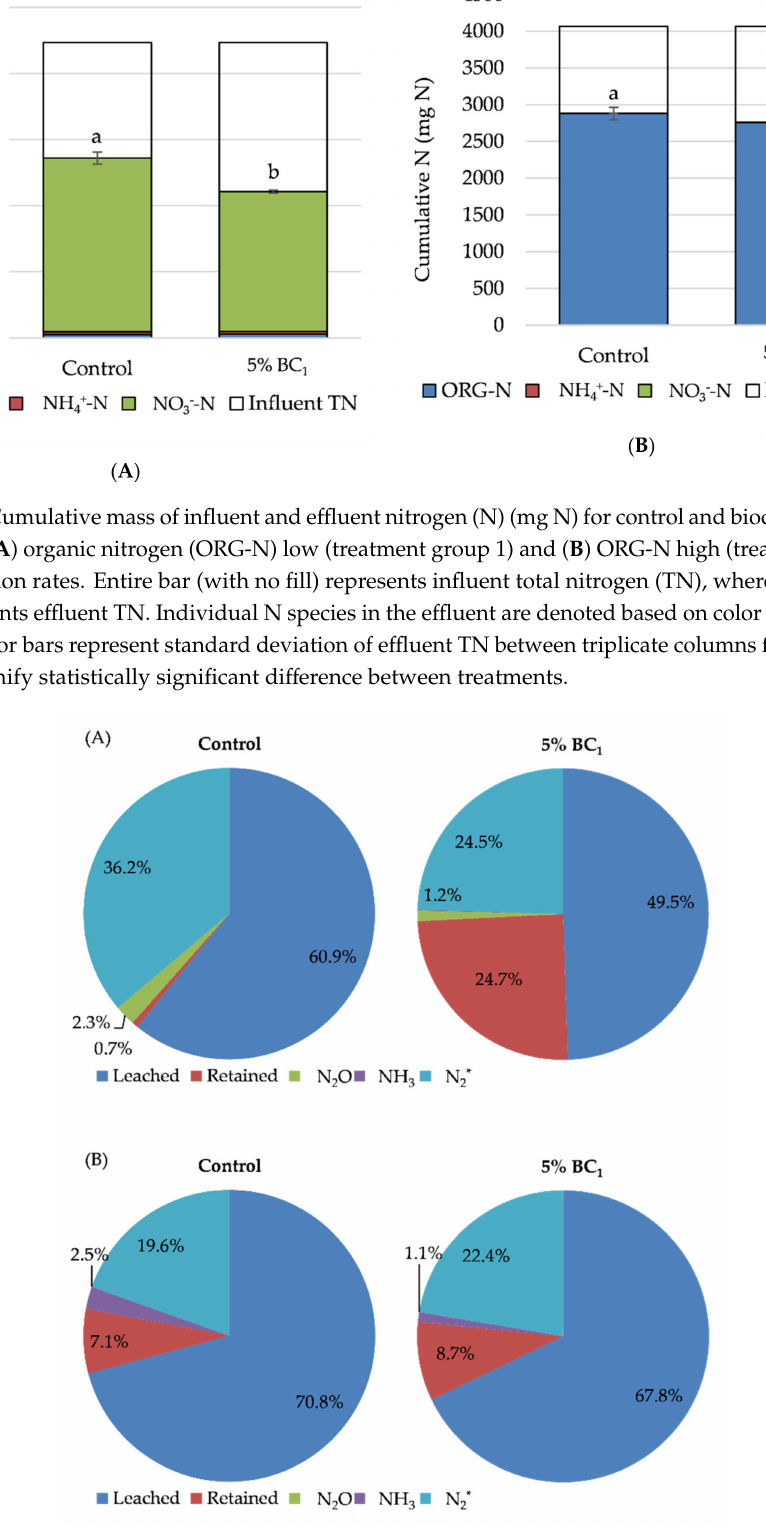
Figure 2. Nitrogen mass balance for influent TN for columns receiving ( A ) ORG-N low (treatment group (1) and ( B ) ORG-N high (treatment group (2) application rates. *Assumed that influent TN unaccounted for in e ffl uent N, retained N, N 2 O, or NH 3 was assumed to be lost as N 2